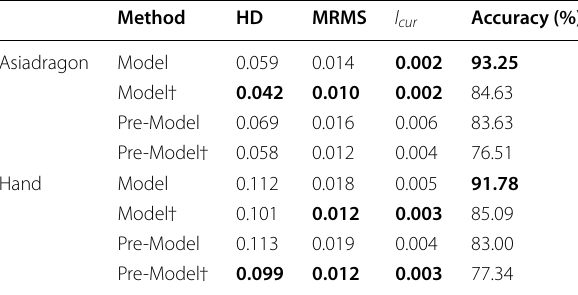
Table 2 Quantitative results on remeshed Hand and remeshed Asiadragon